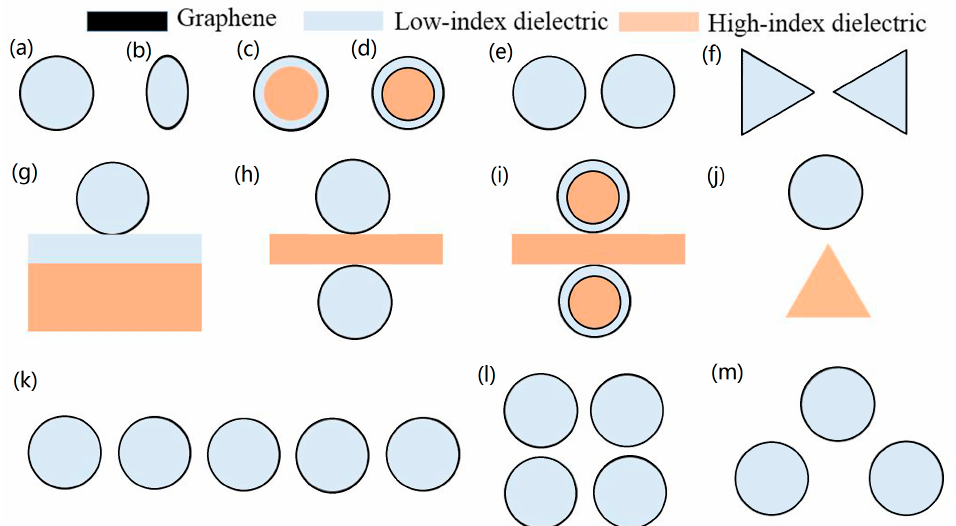
Figure 2. Various graphene-coated nanowire (GCNW)-based waveguides. ( a ) Circular and ( b ) Elliptical GCNWs. ( c ) Coaxial-like and ( d ) Long-range coaxial-like GCNWs. ( e ) Circular and ( f ) Bow-tie GCNW pairs. ( g ) Traditional and ( h ) symmetric GCNW-based hybrid waveguide. ( i ) Modified symmetric and ( j ) Triangle dielectric integrated GCNW-based hybrid waveguides. ( k ) 1D and ( l ) 2D arrays of GCNWs. ( m ) GCNW trimer.